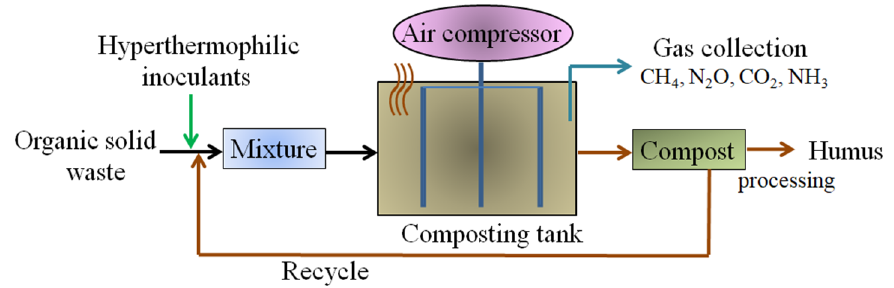
Figure 3. Schematic diagram of hyperthermophilic composting.